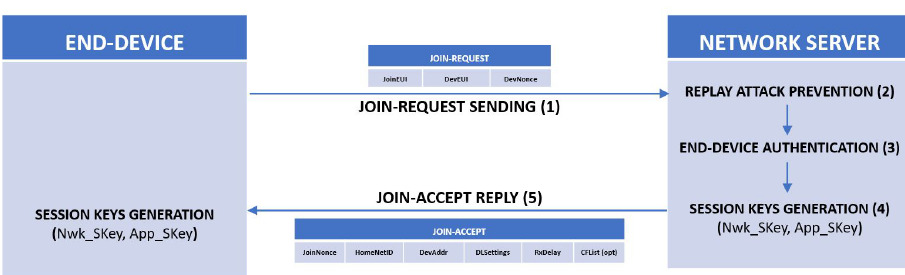
Figure 2. Over-The-Air Activation (OTAA) procedure flow graph.